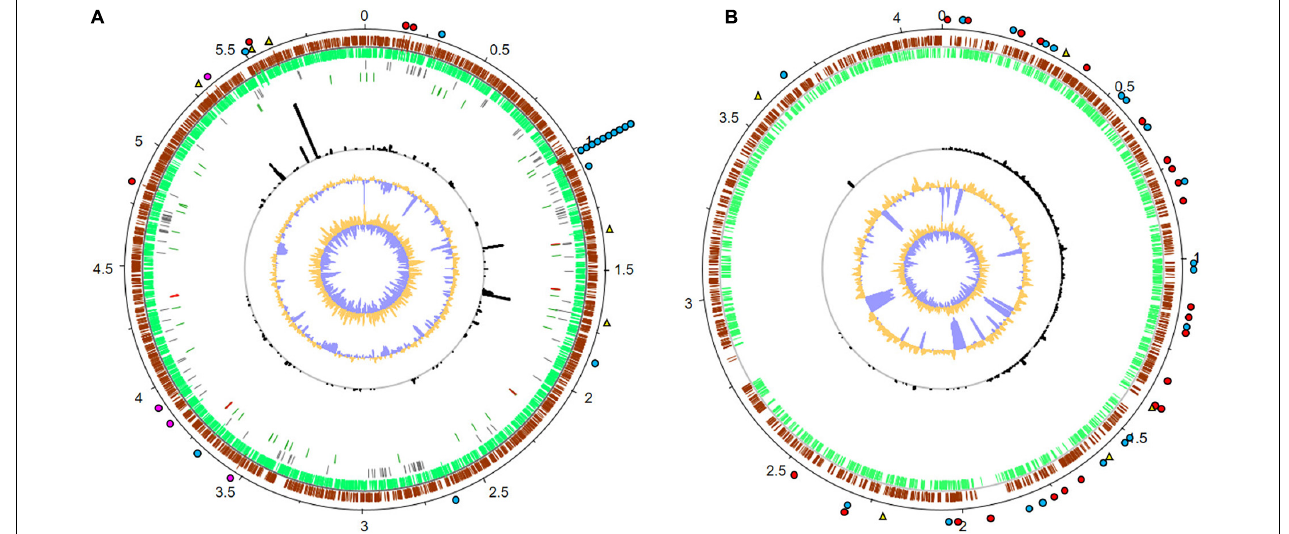
FIGURE 6 | Metatranscriptome mapping to the reference genomes of (A) Methylobacterium brachiatum (GCF_003697185.1) and (B) Amorphotheca resinae (GCA_003019875.1). Numbers outside the circles show the genome coordinates in Mbp. Moving inward, the subsequent two rings show CDSs in forward (brown) and reverse (green) strands. Pseudogenes are displayed in gray; genes coding for tRNAs and rRNAs are marked in dark green and red, respectively ( M. brachiatum only). Black bars indicate RPKM values for each CDS and are displayed in the same scale for (A,B) . The last two inner plots indicate GC content and a GC skew [(GC)/(G + C)], where dark yellow and purple indicate values above and below average, respectively. The top 5 most expressed genes are denoted with a yellow triangle. Genes associated with kerosene degradation are marked with a red dot, potential mechanisms involved in polymer degradation with a blue dot, and genes for biofilm formation with a pink dot. For real RPKM values and further details, see Supplementary Table 6